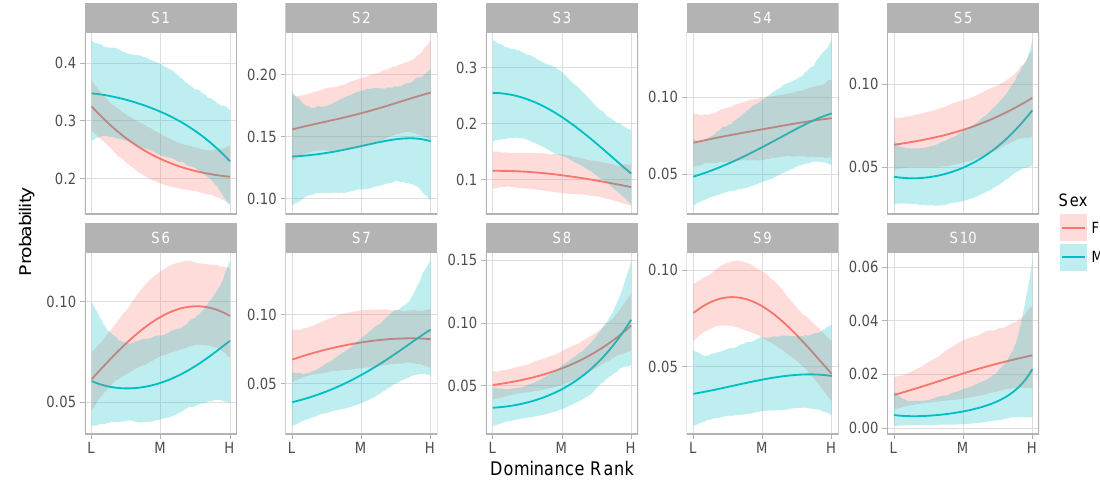
Figure 6. Relationship between dominance rank and the expected probability of being in a state for animals of average age in group F. Curves represent posterior means and shaded regions, 95% central credible intervals of the value of the curve at the corresponding